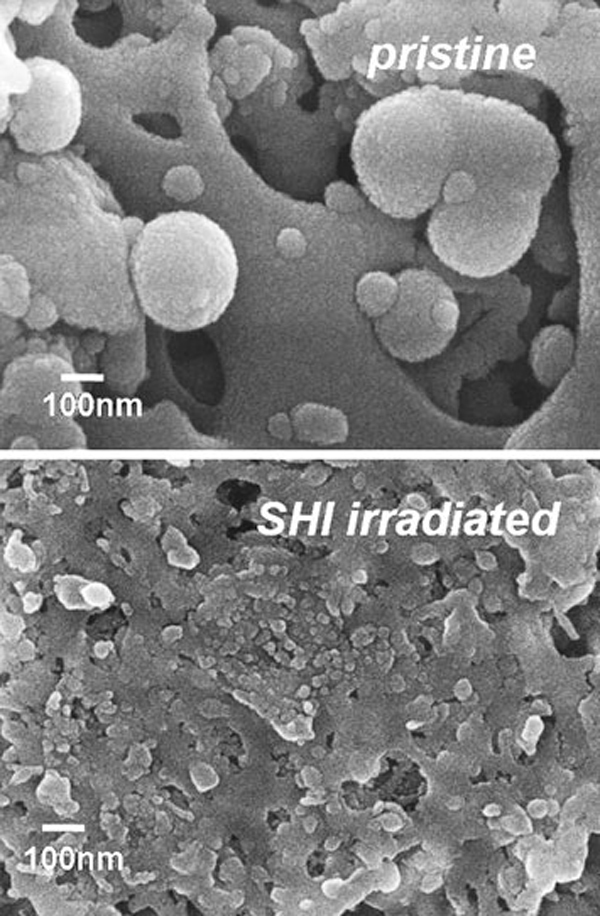
Scanning electron microscopy images of pristine and O2 ion-irradiated TiO2 compact layer.